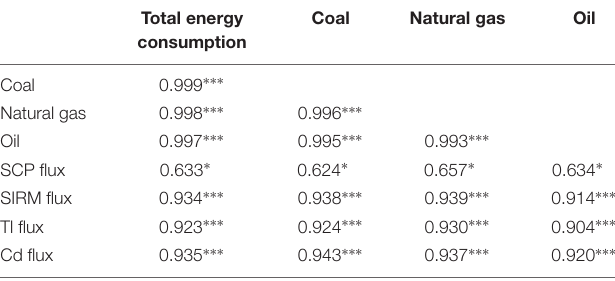
TABLE 5 | Correlations between consumption of total energy, coal, oil and natural gas in Chongqing (1949–2013; n = 42) and SKP flux data: SIRM ( n = 42), SCPs ( n = 13), Tl and Cd ( n = 27) corresponding to Figure 6